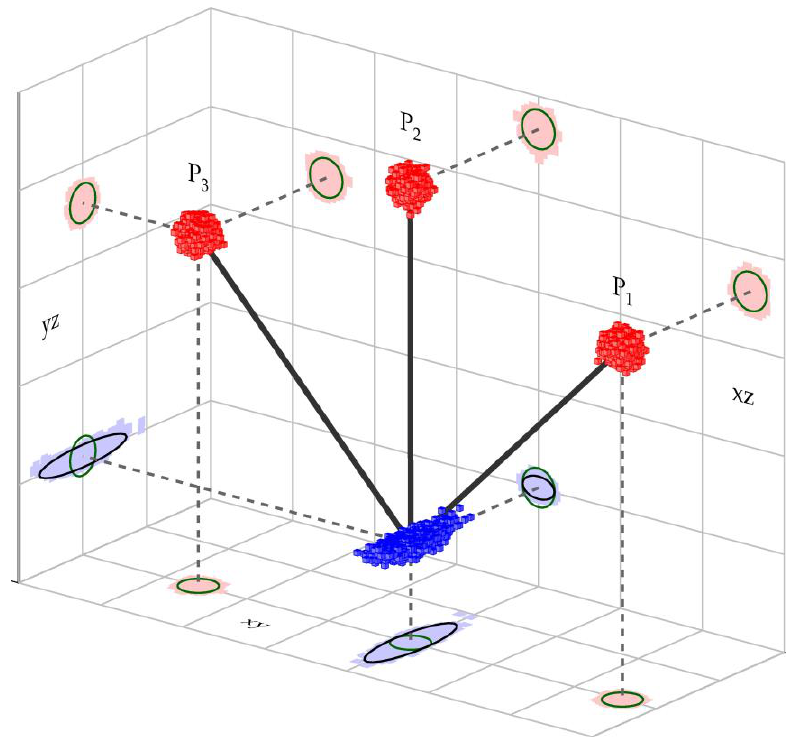
Figure 7. Quality assessment of characteristic point 𝐂 .